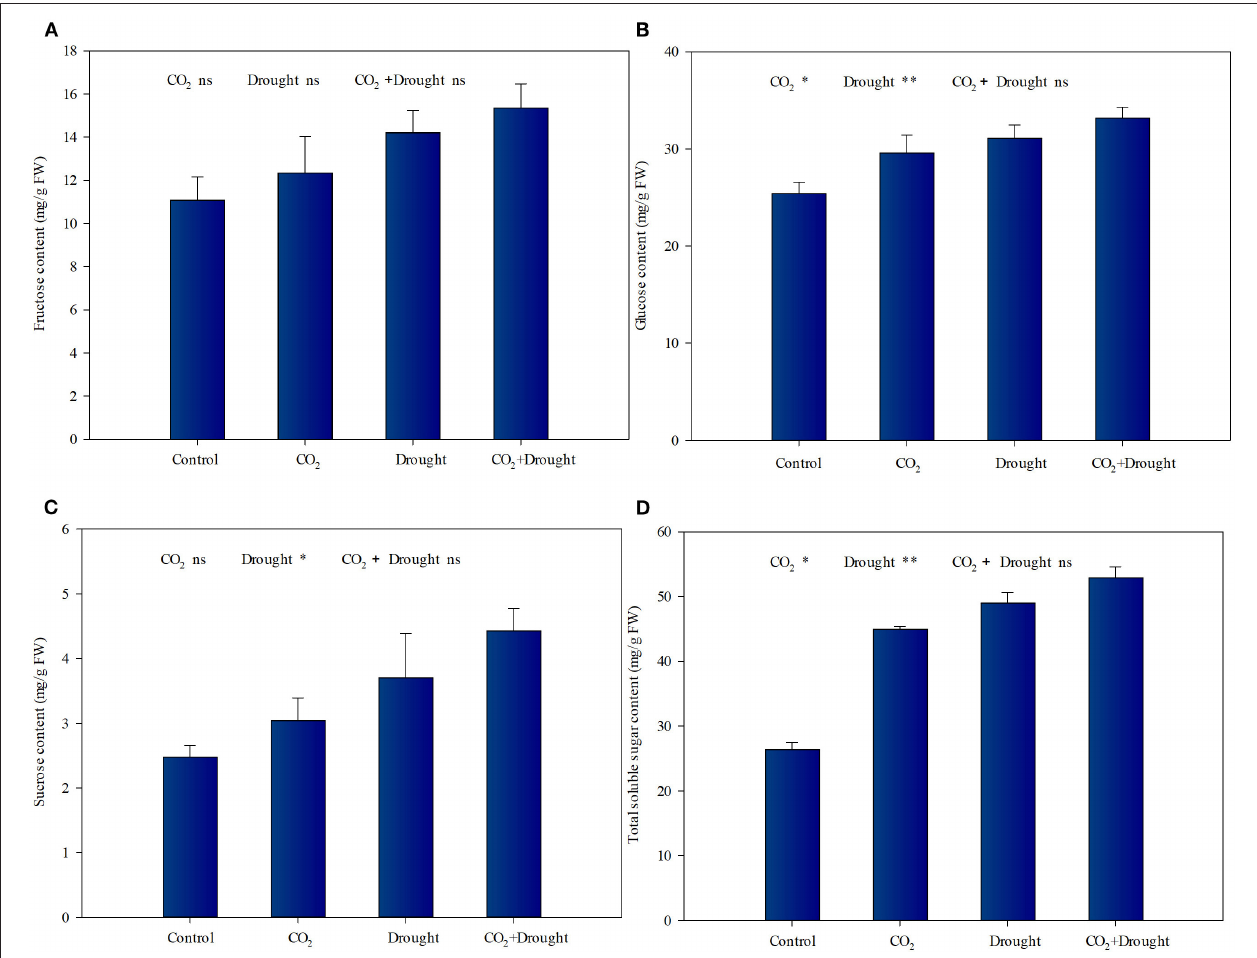
FIGURE 2 | Soluble sugars content of Triticum aestivum grown under elevated CO 2 and drought conditions. (A) fructose; (B) glucose; (C) sucrose; (D) total soluble sugars. Each value shown represents the mean ( ± SE) of three replicates. P- values are provided for two-way ANOVA on the effects of elevated CO 2 and drought treatments on soluble sugar content. Significant differences: * P < 0.05; ** P < 0.01; ns, P >